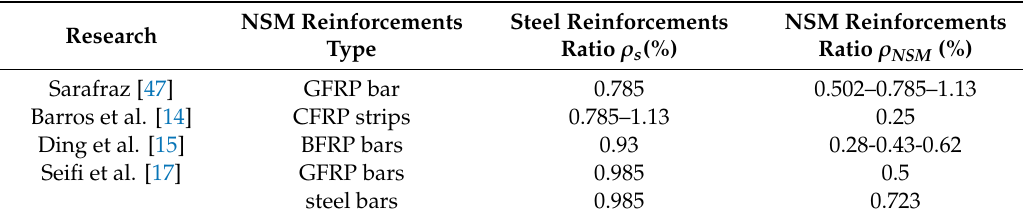
Table 5. Near-surface mounted (NSM) reinforcement ratio of at some